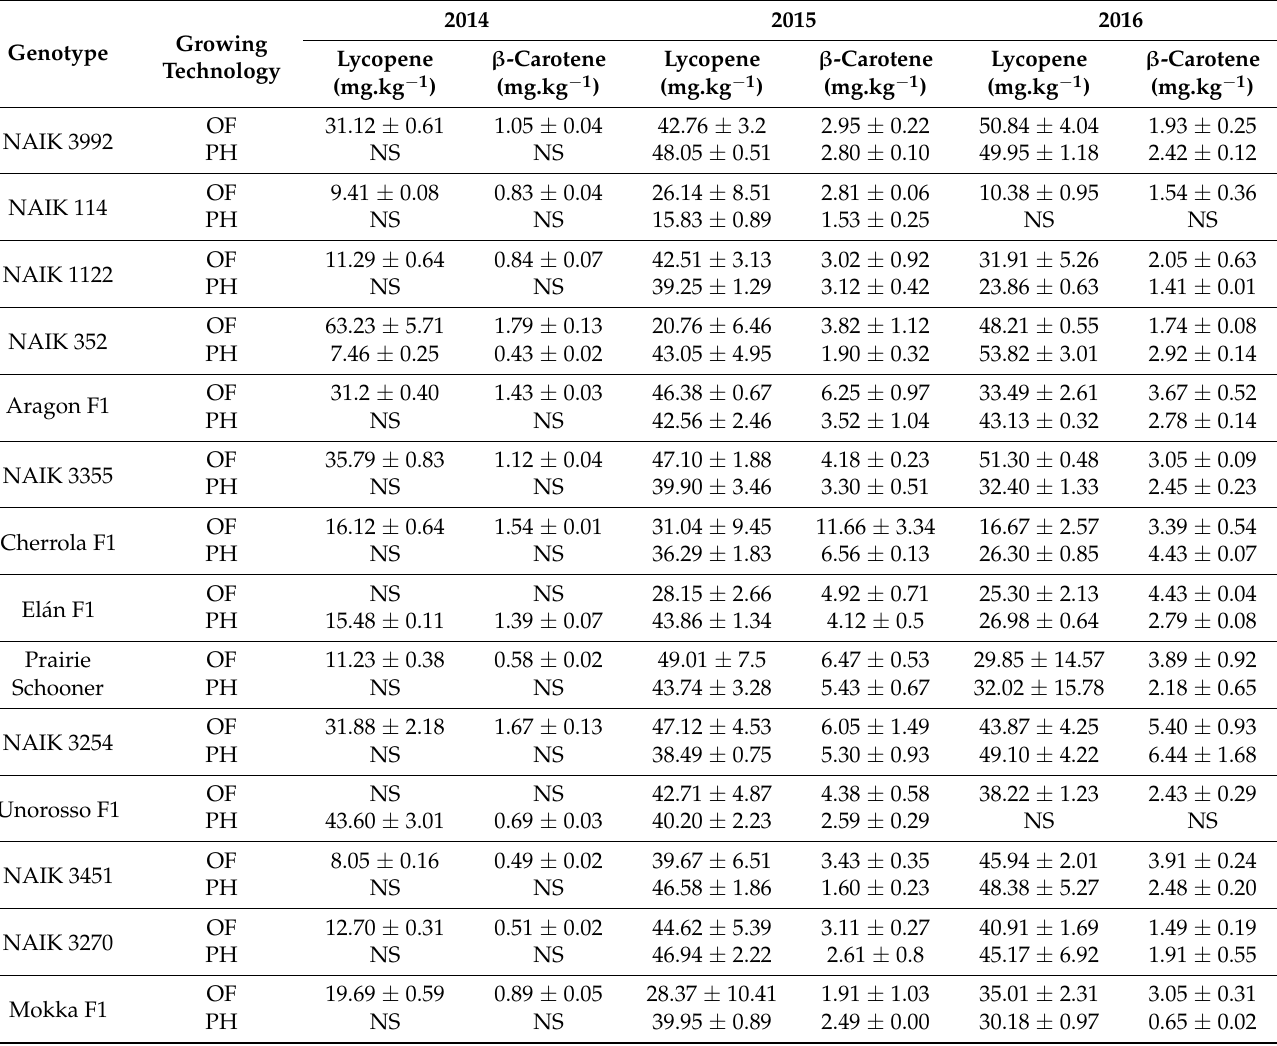
Table 1. Lycopene and β -carotene concentrations in tomato samples during 2014–2016 under different growing technology (NS—no samples; OF—open field; PH—plastic